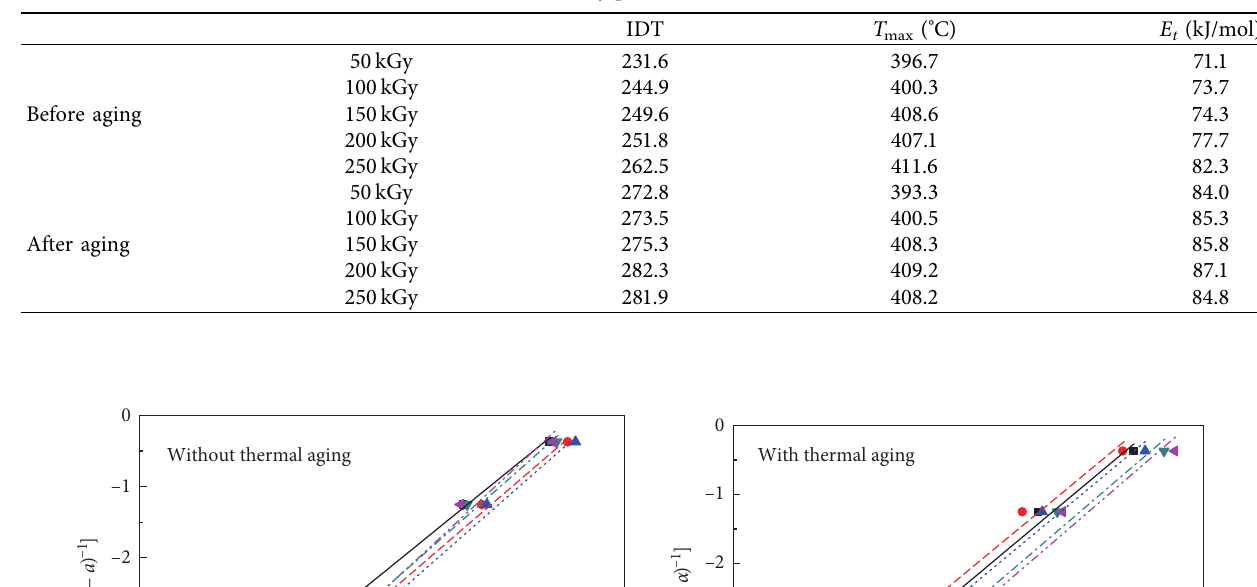
Table 5: Thermal stability parameters of the BR/NR